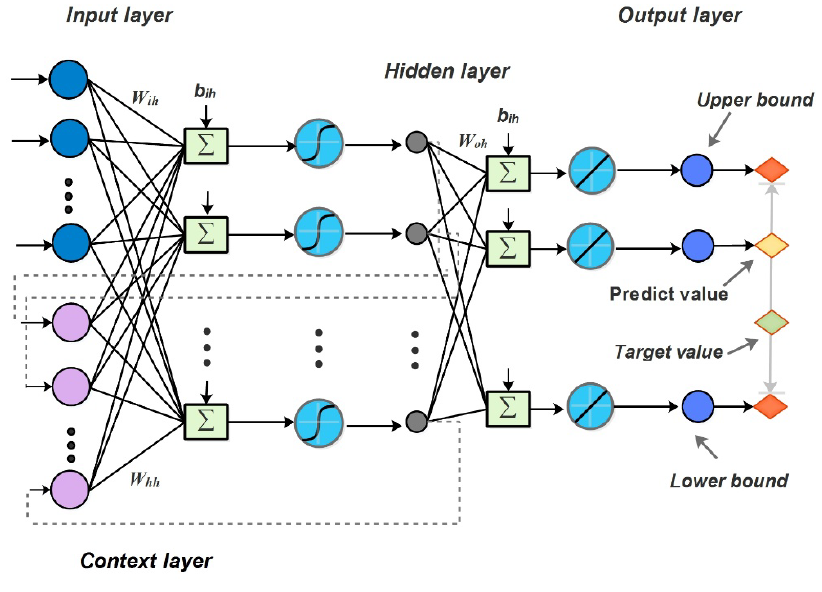
Figure 1. The structure of the lower bound and upper bound estimation (LUBE) based on the Elman neural network.